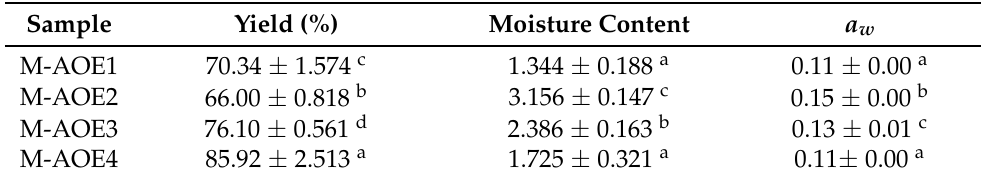
Table 3. Influence of mixed particulate emulsifiers (AOE1, AOE2, AOE3, AOE4) on the yield, moisture content, and a w of spray dried